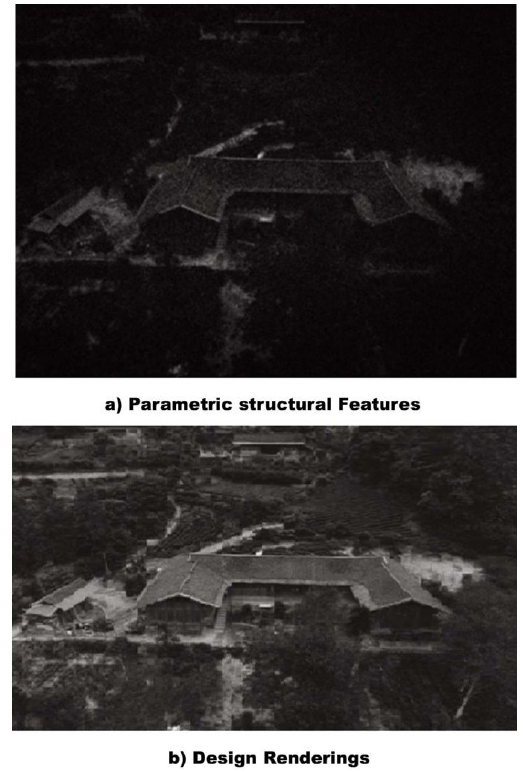
Figure 4: Landscape design results